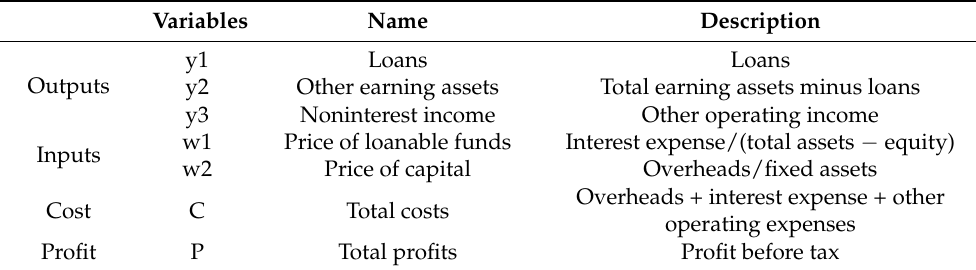
Table 1. Definition of the variables included in the cost and profit